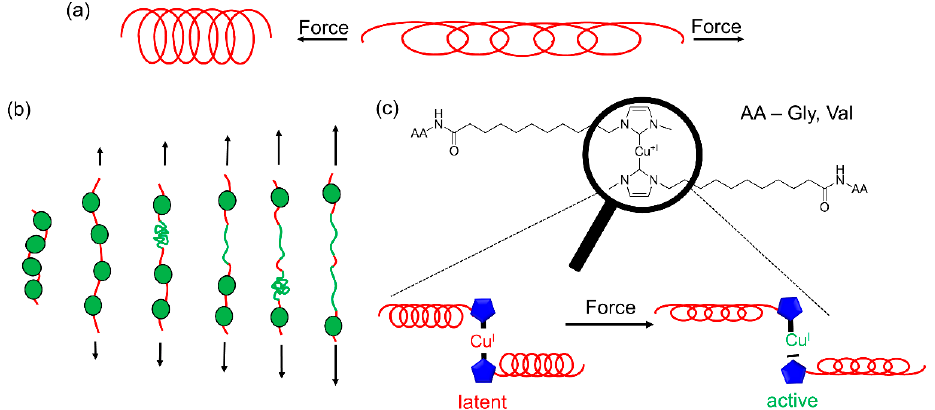
Figure 1. Energy dissipation mechanisms in proteins. ( a ) “Molecular spring” behavior and ( b ) stepwise unfolding of single protein domains under stress. ( c ) Top: Molecular structure of the low molecular weight catalysts bearing an amino acid (glycine or L -valine). Bottom: Exploitation of the “molecular spring” behavior for an efficient force transmission to facilitate the cleavage of the Cu–carbene bond.